Question: In one sentence, what is this figure communicating?
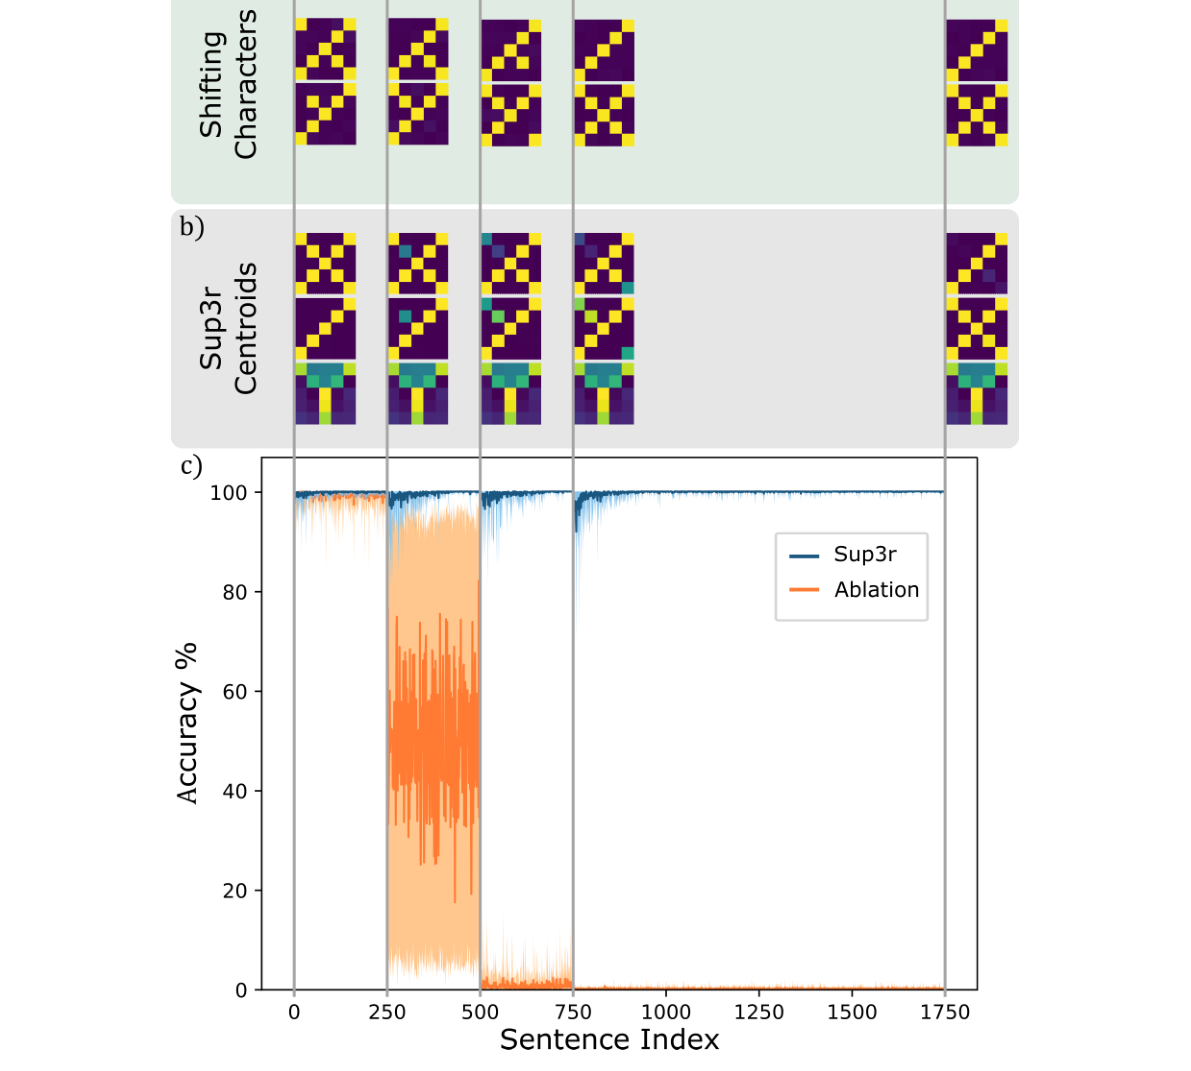
Answer: Continual learning test with Sup3r. In this test, we perform a class shift in the two sentences by subtracting pixels from ”x” and adding them to ”/” every 250 sentences (a), with the final shift lasting 1000 sentences. Sup3r centroids slowly adapt to the shift (b). In (c), Sup3r network accuracy remains high and returns to >99%, while the same network without unsupervised learning fails the task (Ablation). This test is performed with ten independently trained networks and randomized test sets. Accuracy is reported as the average across runs in dark colors with min and max values in light colors.